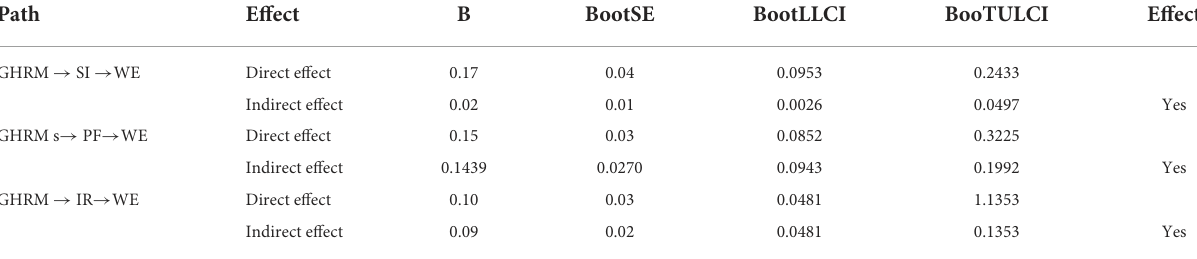
TABLE 8 Psychological ownership sub-dimensions mediation analyses results.